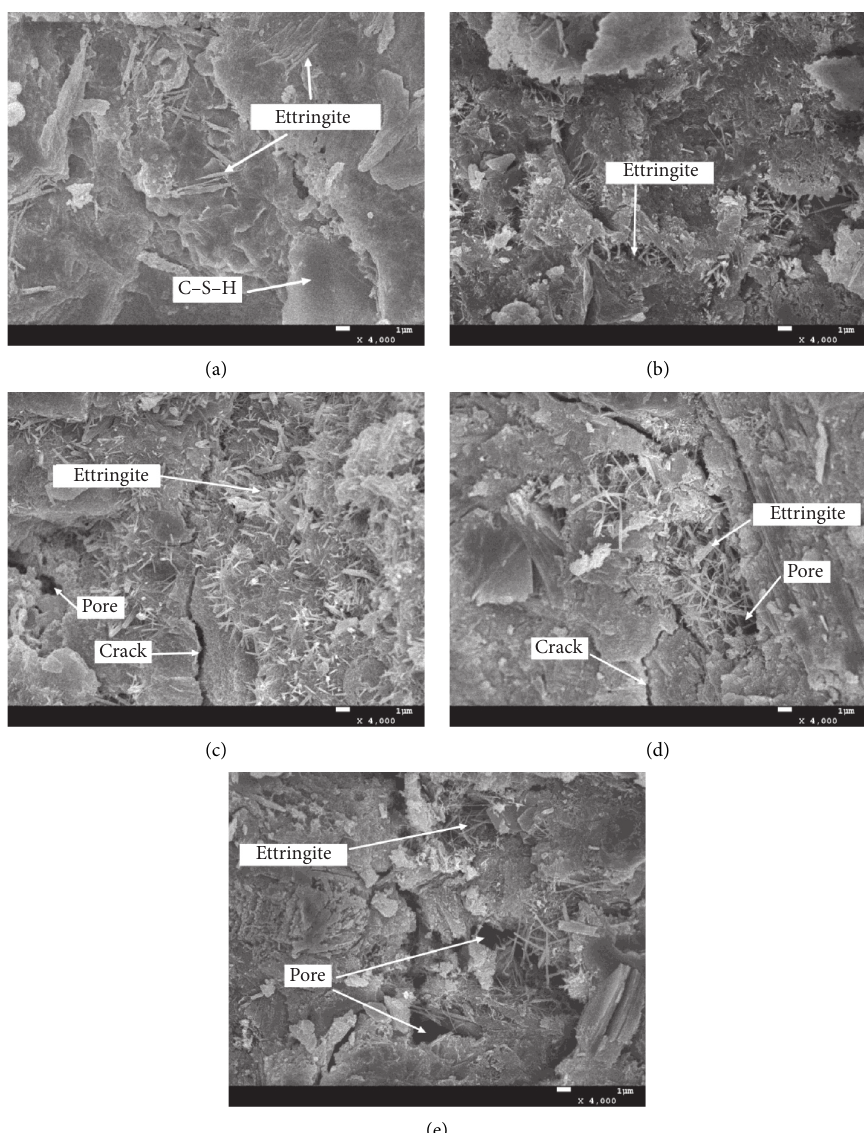
Figure 6: Microstructure of the concrete in the IFT environment. (a) 0 freeze-thaw cycles; (b) 25 freeze-thaw cycles; (c) 50 freeze-thaw cycles; (d) 75 freeze-thaw cycles; and (e) 125 freeze-thaw